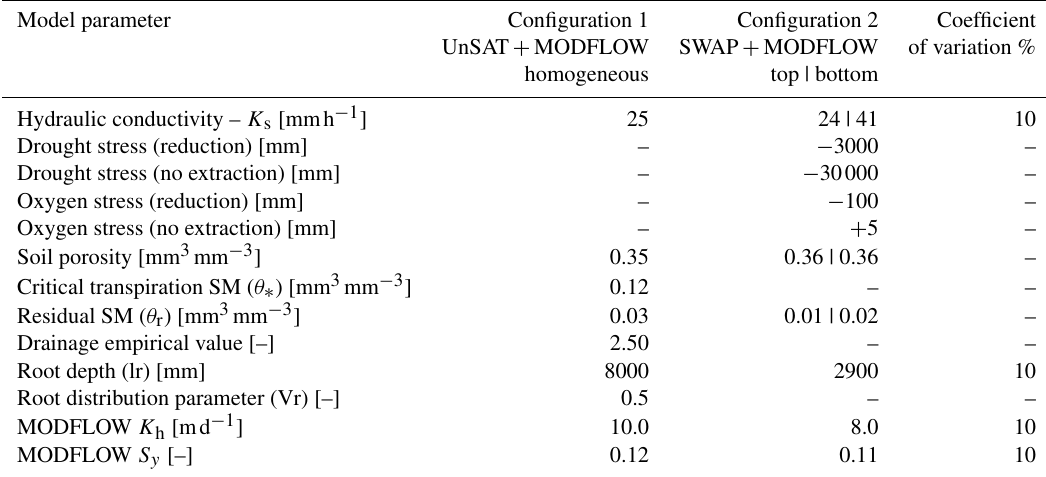
Table 1. Calibrated parameter values used for the simulations and their coefficient of variation. Model